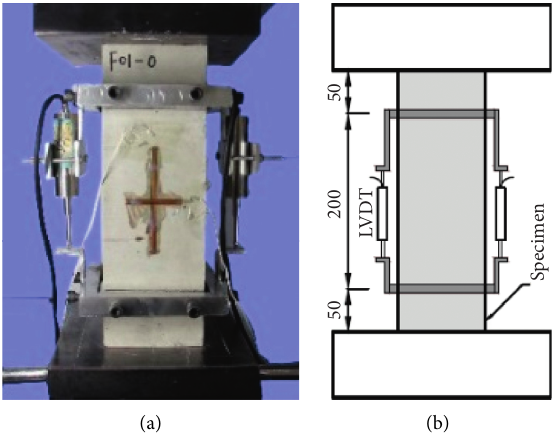
Figure 5: Loading device of compressive strength test. (a) Actual loading map of test. (b) Loading sketch map of